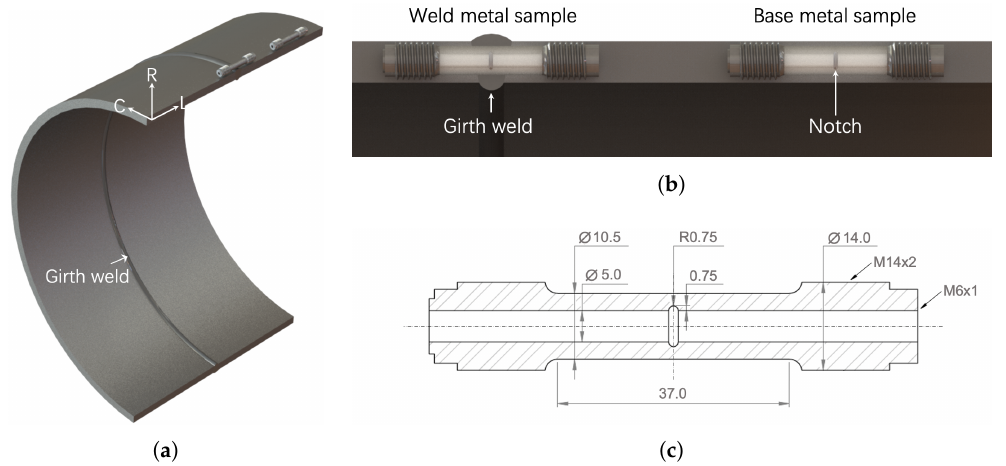
Figure 3. ( a ) Illustration of a cross-section of an X60 pipe including the girth weld and two samples, from which the orientations of the prepared samples can be derived: L—Longitudinal, C—Circumferential and R—Radial. ( b ) The zoomed-in normal projection of the pipe wall, which identifies the two samples as a weld metal and base metal sample. The transparent view of the gauge allows the orientation of the notch in the material to be seen. ( c ) Engineering drawing showing the geometry of the specimen and notch. Dimensions are in